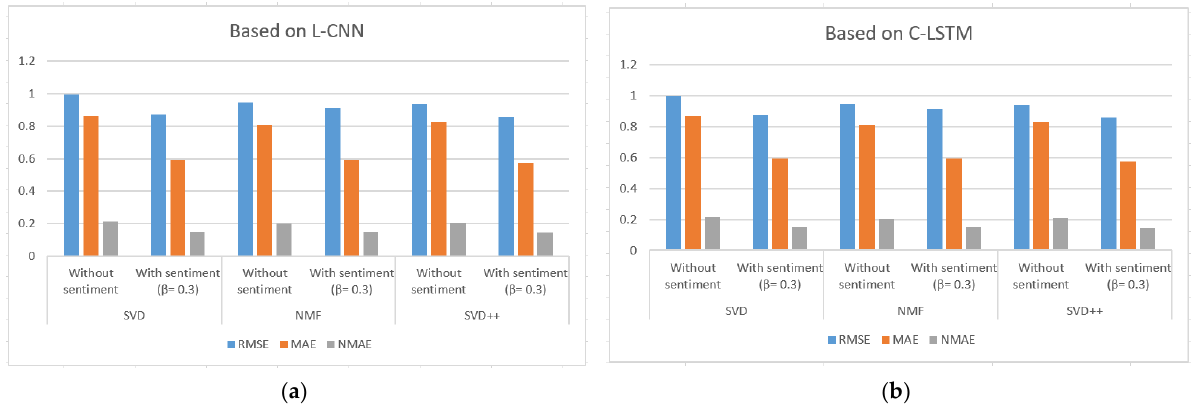
Figure 10. Comparison of the sentiment-based methods with the L-CNN model ( a ) and the C-LSTM ( b ) and β = 0.3 against non-sentiment-based methods on Amazon Movie Reviews. Table 6. MRR, MAP and NDCG values without and with L-CNN sentiment model on Amazon Fine Foods Reviews with β = 0.7.